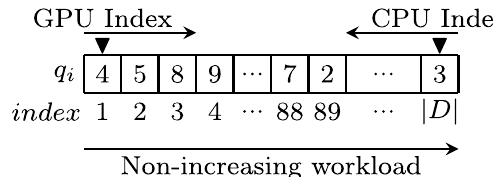
Fig. 2 Representation of our deque as an array. The numbers q i are the query points id, the triangles are the starting position of each index, and the arrows above it indicate the indices progression in the deque